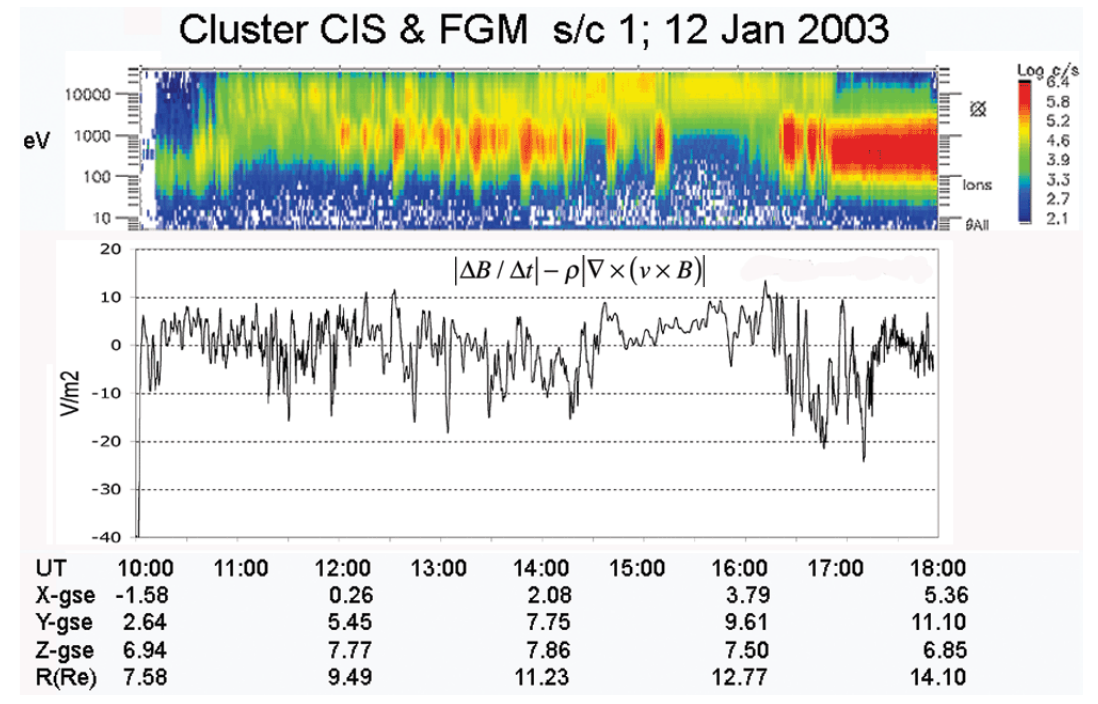
Fig. 10. Graph illustrating | 1 B /1t |− ρ |∇× ( − v × B ) | (Eq. 6) versus time for the 12 January 2003 Cluster case. The magnetopause is traversed at ≈ 17:00